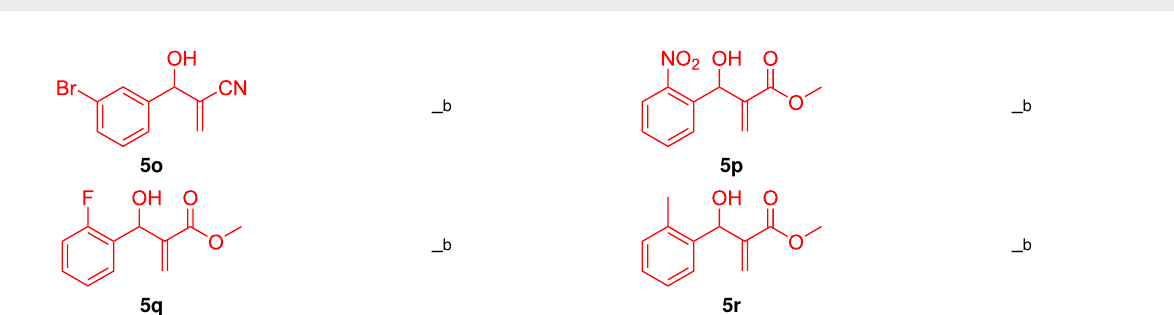
Table 2: Scope of Morita–Baylis–Hillman adducts. a (continued)